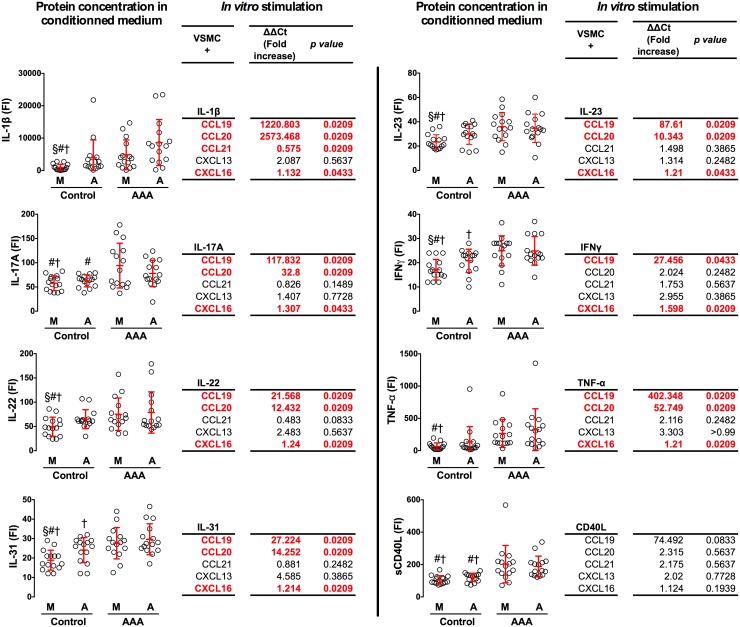
Inflammatory chemokines produced in AAA tissues trigger the expression of chemokines by VSMC.The graphs represent the relative concentrations of IL-1β, IL-17A, IL-22, IL-31, IL-23, IFNγ, TNF-α and CD40L that were assessed by ELISA assays on conditioned medium prepared from the media (M) and adventitia (A) of AAAs (n = 15) and control aortas (n = 15; §, #, †, p<0.05 vs Control A, AAA M and AAA A, respectively). The tables represent the expression of CCL19, CCL20, CCL21, CXCL13, and CXCL16 chemokines by human VSMCs that were stimulated for 15 hours with rIL-1β (5 ng/mL), rIL-17A (50 ng/mL), rIL-22 (10 ng/mL), rIL-31 (50 ng/mL), rIL-23 (25 ng/mL), rIFNγ (10 ng/mL), rTNF-α (1 ng/mL), and rCD40L (100 ng/mL). These cytokine concentrations were 2 log higher than those detected in the conditioned medium, so as to compensate for the in vivo situation where cells are subjected to chronic, additive and combined stimulations. The relative expression was determined by RT-qPCR on extracted RNA, and data were analyzed using the 2−ΔΔCt Pfaffl formula [30] in which Ct values from stimulated VSMCs were compared to unstimulated cells, and normalized to the Ct values of β-actin. Data are representative of 4 independent experiments.